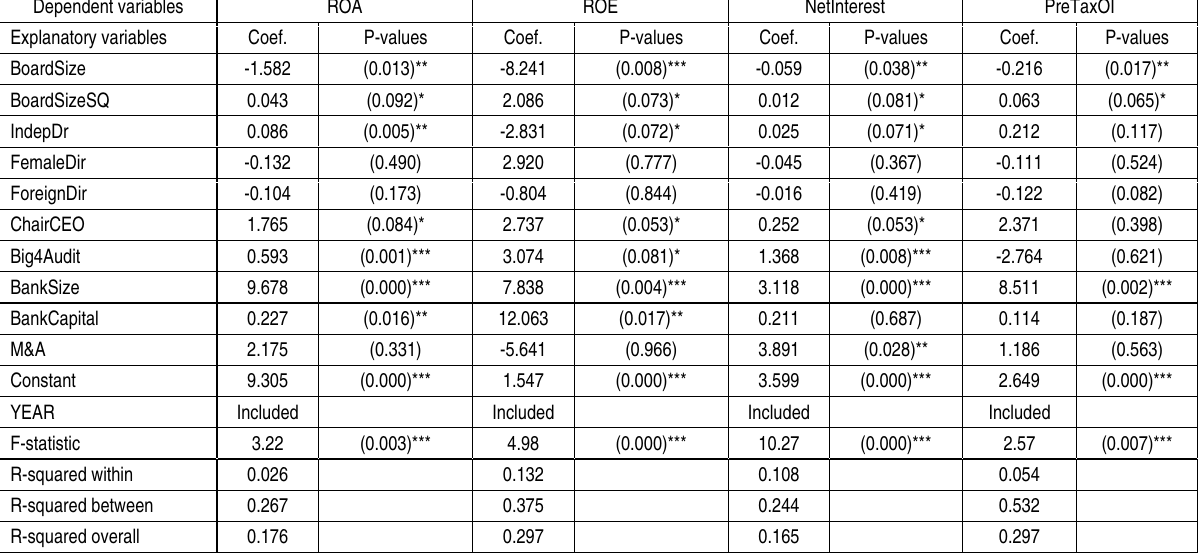
Table 3. Fixed effects empirical findings with the inclusion of